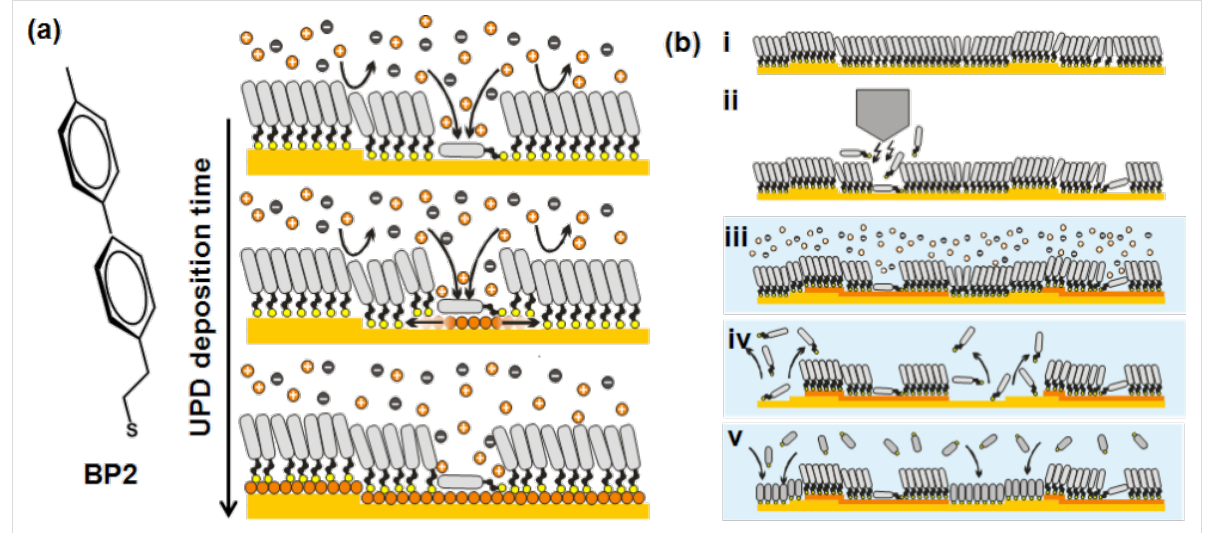
Figure 1: (a) Mechanism of Cu-UPD onto a BP2-modified Au(111) surface with the deposition starting at defects and the UPD proceeding by lateral diffusion of the metal atoms at the SAM–substrate interface. (b) Scheme illustrating the steps in UPD-based patterning. For details see